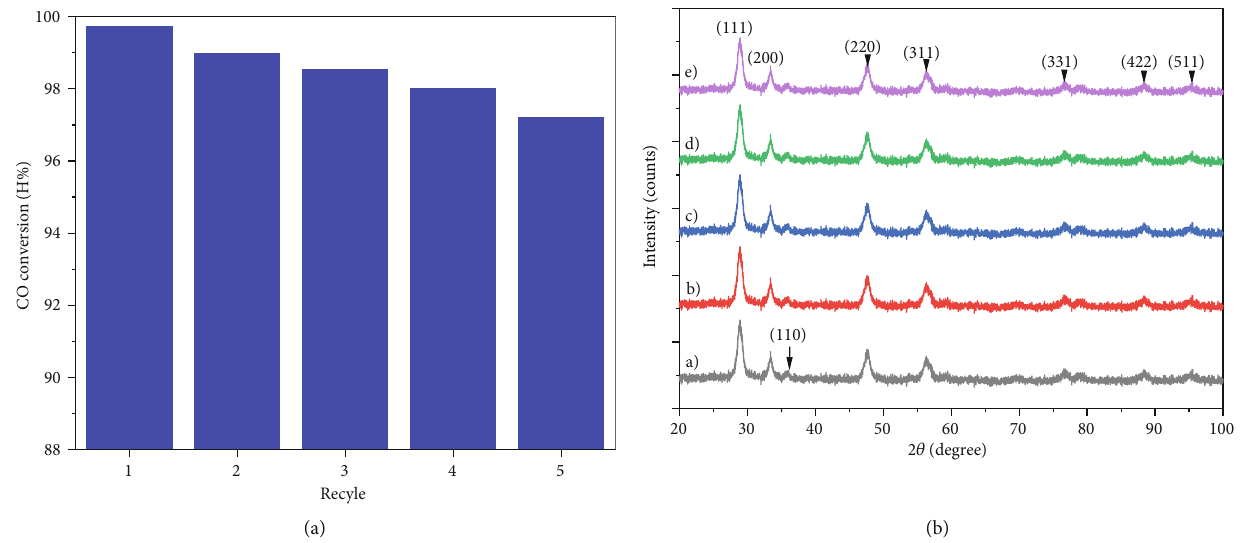
Figure 10: CO conversion of sample CF650(CF11) at T 4 th , and (E) 5 th